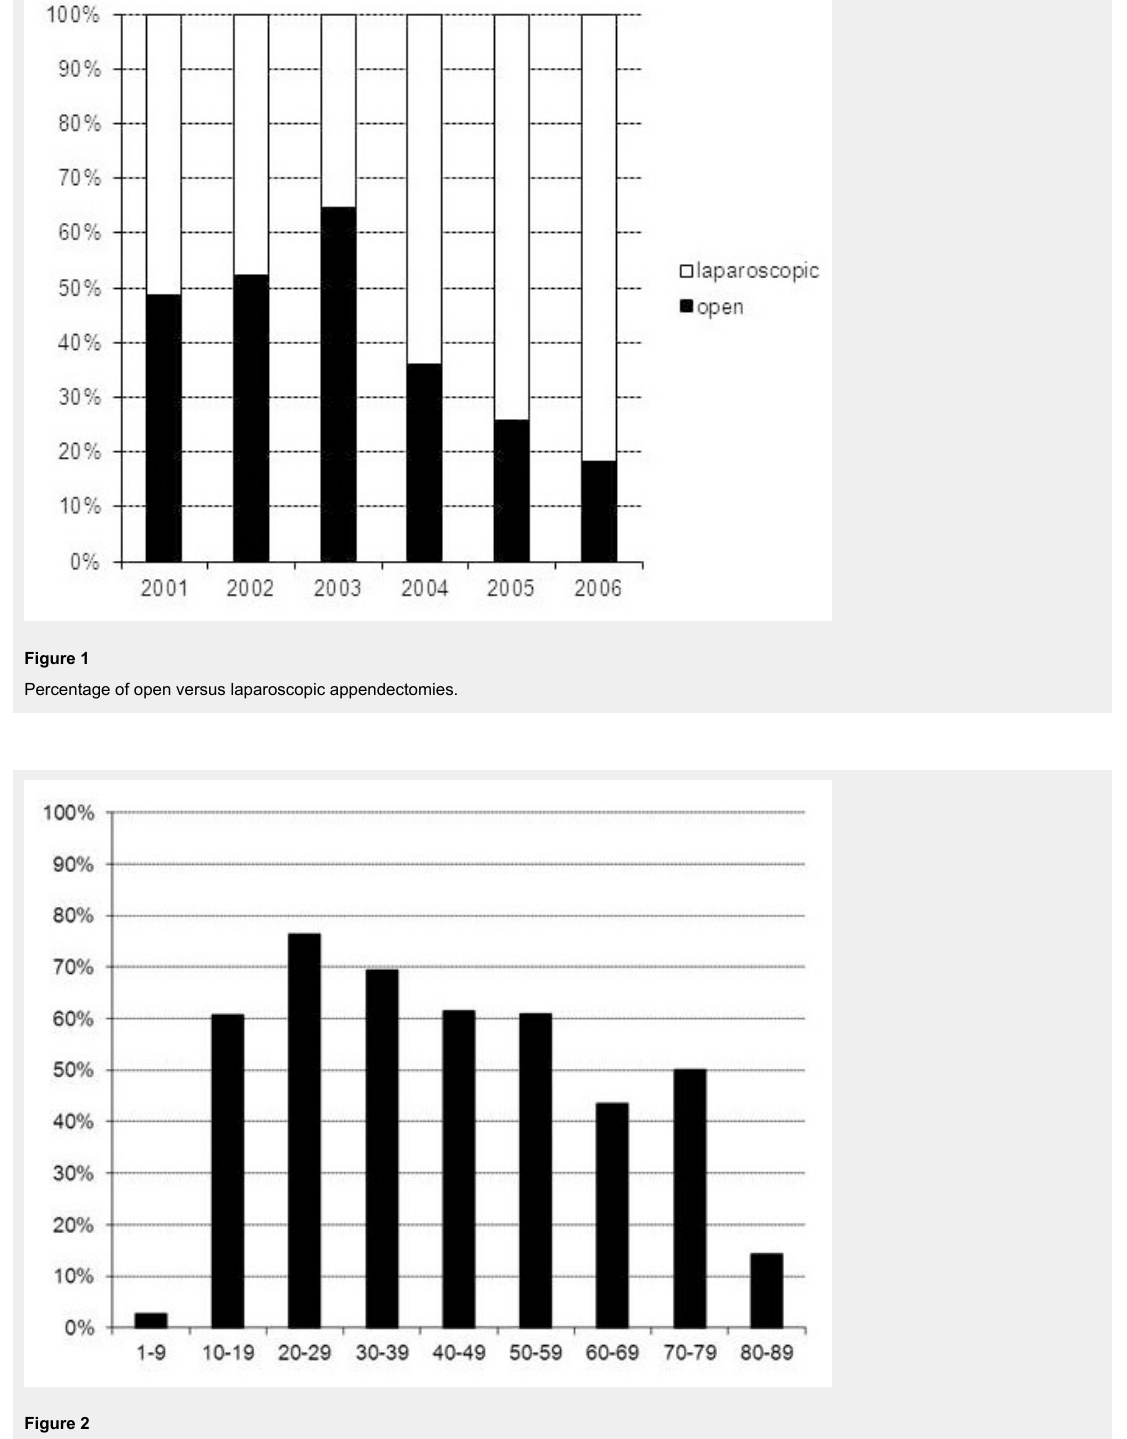
Figure 2 Percentage of laparoscopic procedures by age of the